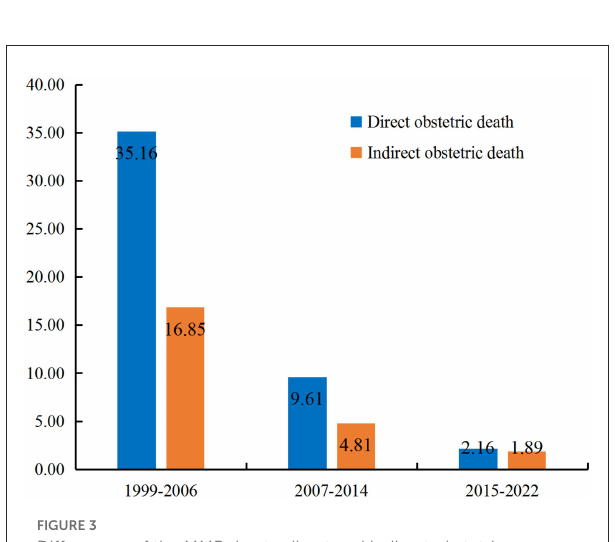
FIGURE3 Differences of the MMR due to direct and indirect obstetric causes in different periods.